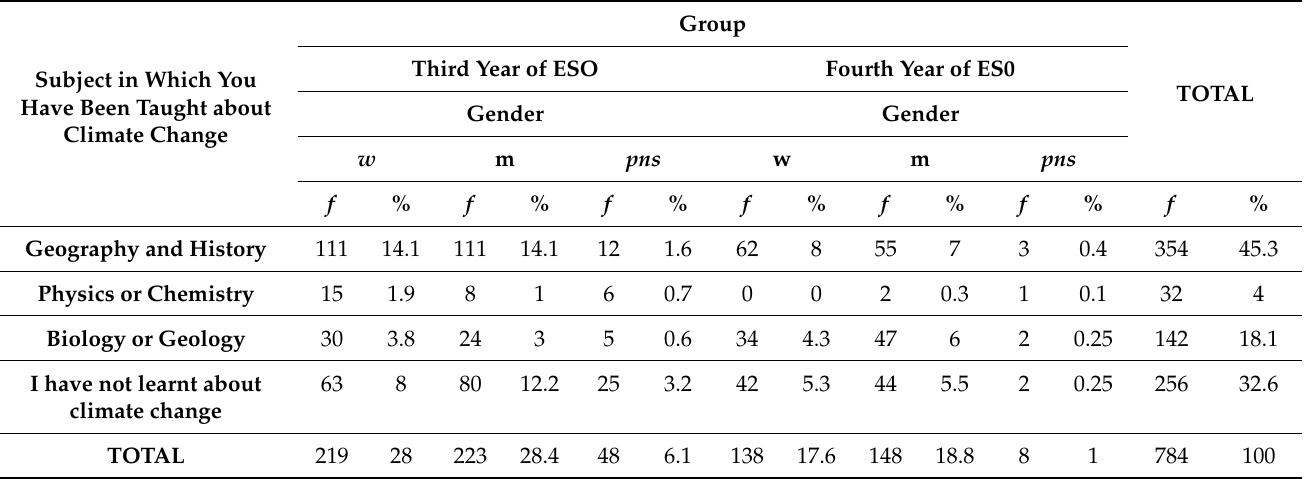
Table 3. Frequency and percentages of the perception of the students by year and gender of the subject in which climate change is